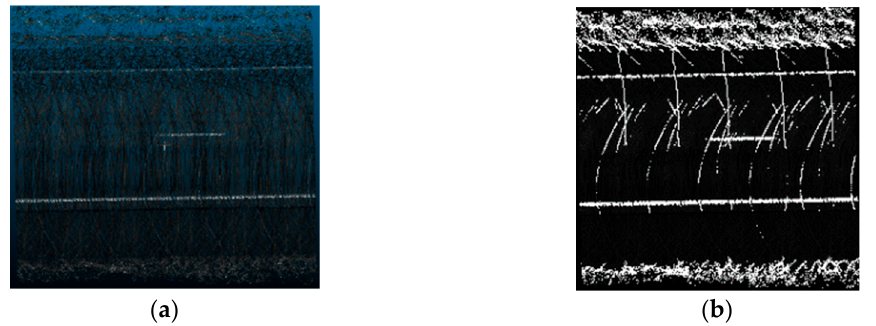
Figure 10. Illustrations of ( a ) original road surface point cloud block and ( b ) corresponding intensity image.